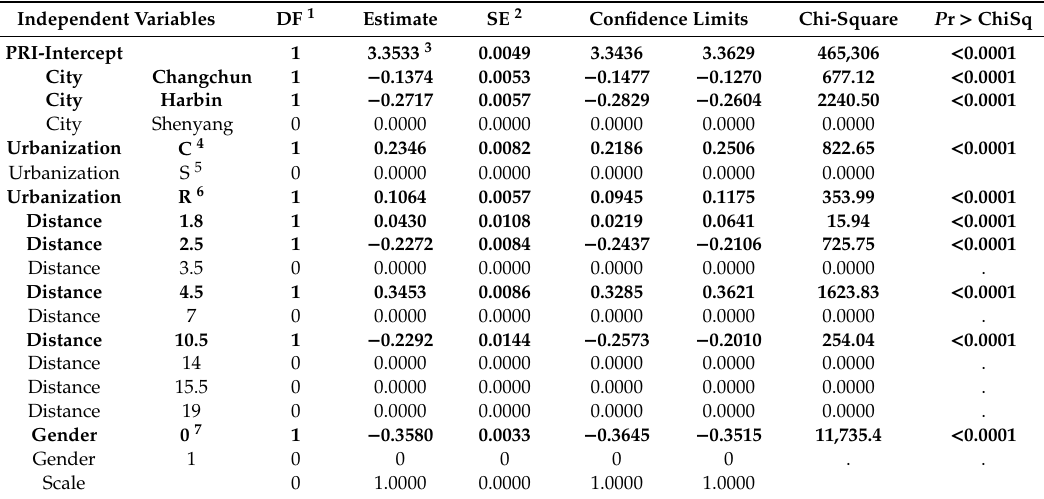
Table 4. Analysis of parameter estimates of e ff ects from independent variables of city di ff erence, urbanization level, distance to the city center, and visitors’ gender on the dependent of descending ranks of positive response index (PRI) given by the Poisson